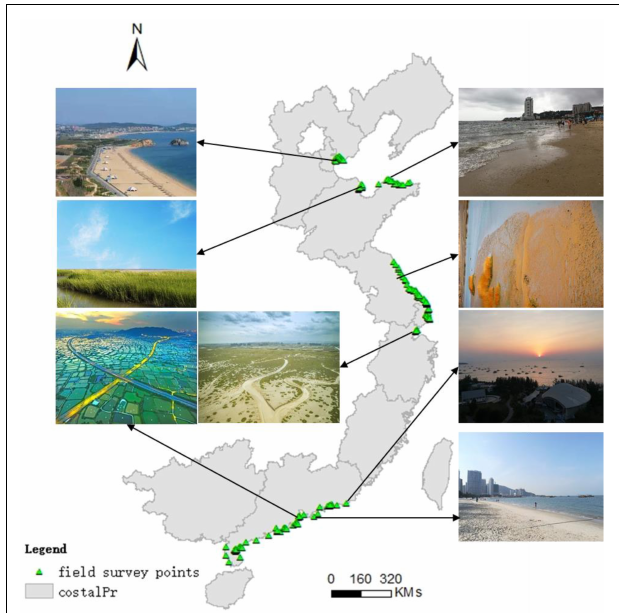
FIGURE 4 | Distribution of the field survey points.